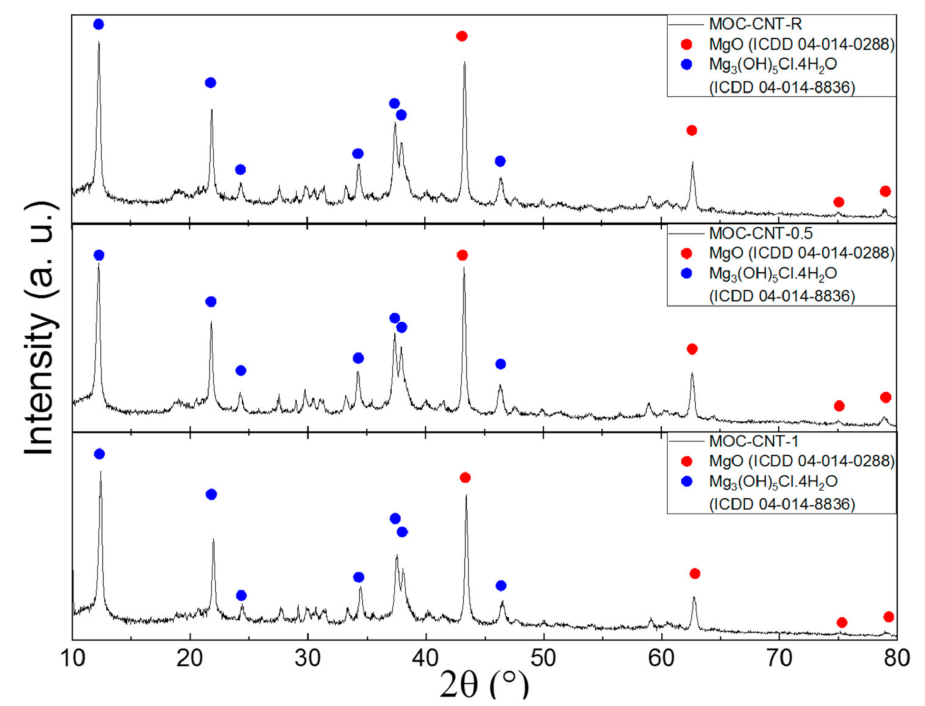
Figure 3. Diffraction patterns of the samples MOC-CNT-R, MOC-CNT-0.5, and